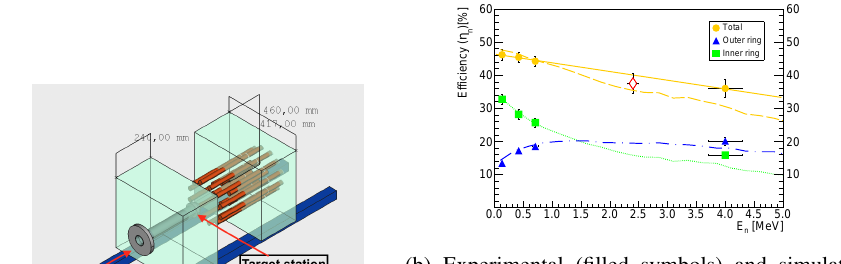
(b) Experimental (filled symbols) and simulated (dashed line) e ffi ciency curves[8] of the horizontal setup. E ffi ciencies related to the inner (squares and dotted lines) and outer (triangles and dash-dotted (a) Drawing of the horizontal neutron detector lines) ring of the setups are also shown, respec- array used for the LUNA measurement[8]. tively. The linear fit of the experimental data (solid lines) allows to interpolate the proposed e ffi ciency value in the experimental region of interest (E n = 2.4 MeV) (empty